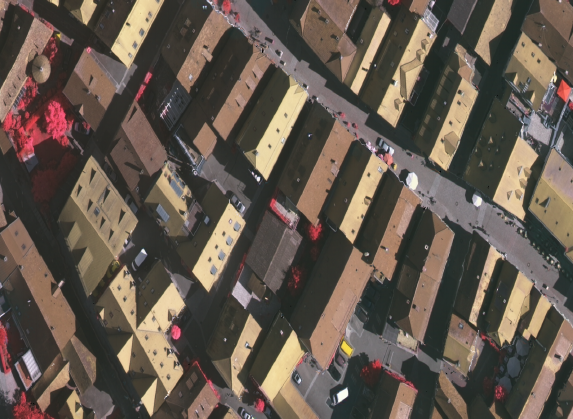
Figure 2. A part of the region of interest in the orthophoto, showing abundance of roof superstructures.